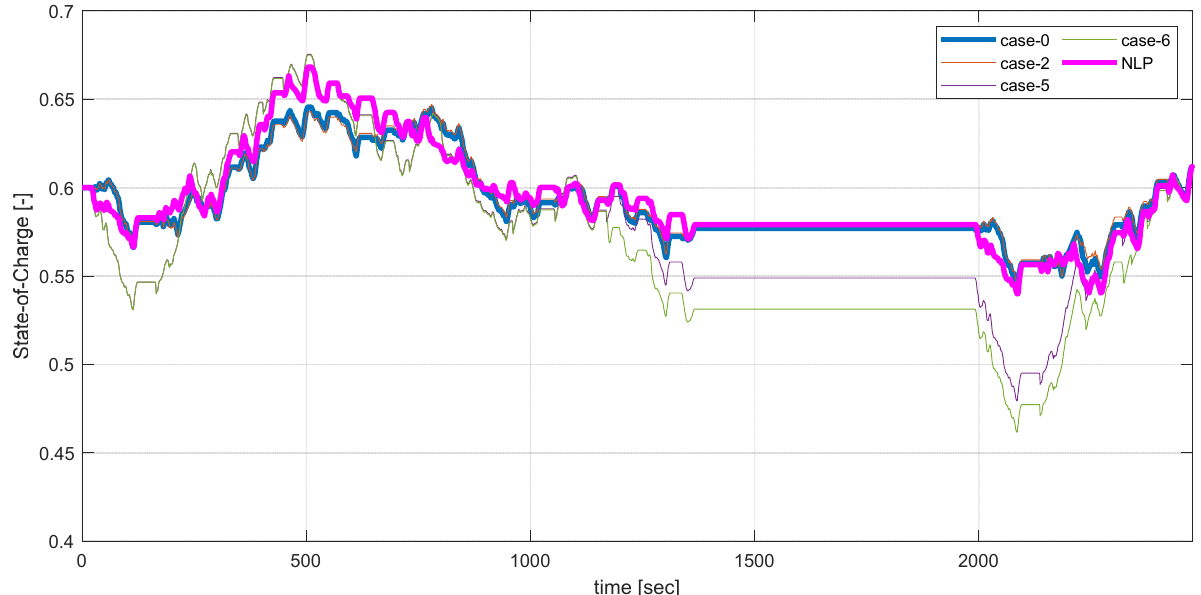
14 of 18 Table 3. Comparison of NLP results and DP results (1): calculation time and sum of error. Case